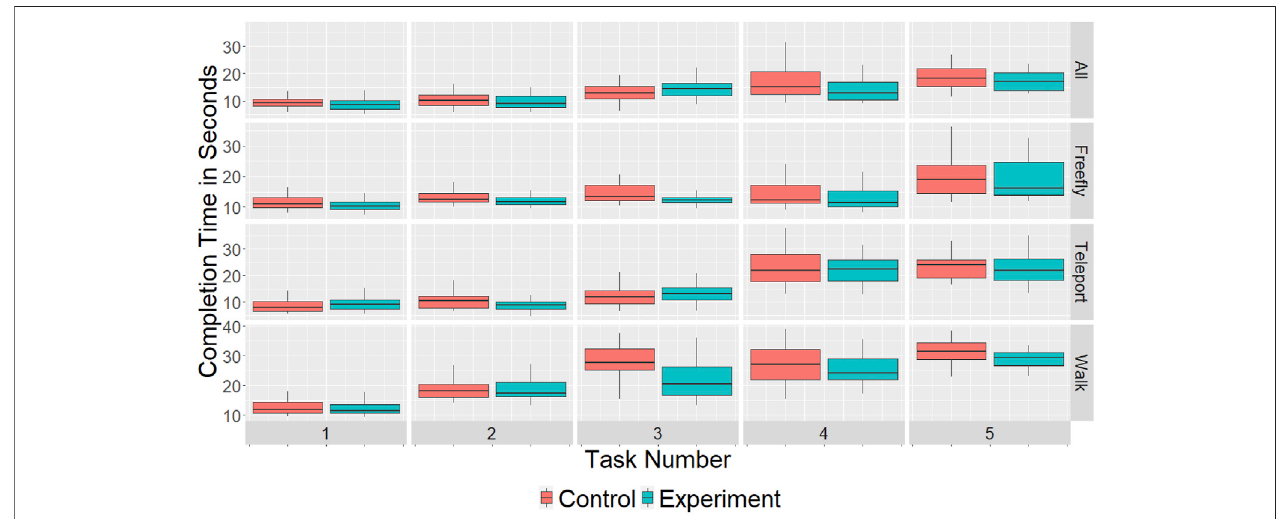
FIGURE 10 | Faceted boxplots of completion times by task number (horizontal) per round (vertical).